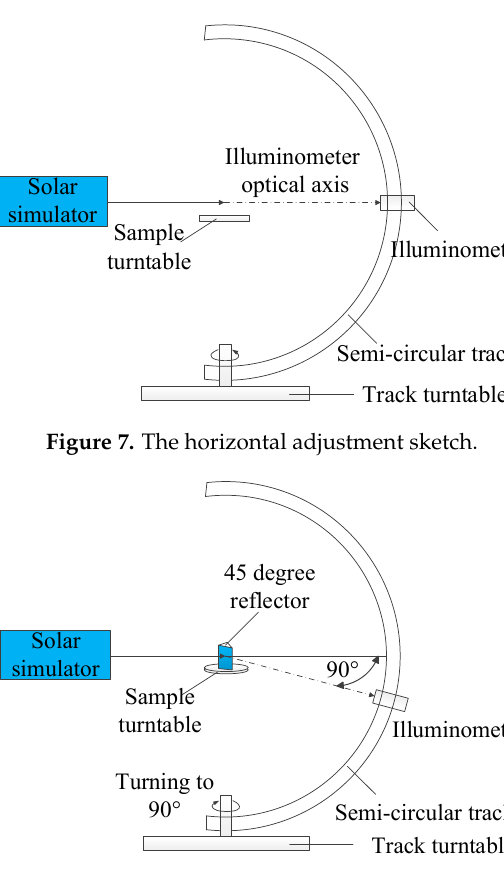
Figure 8. The concentric adjustment sketch.